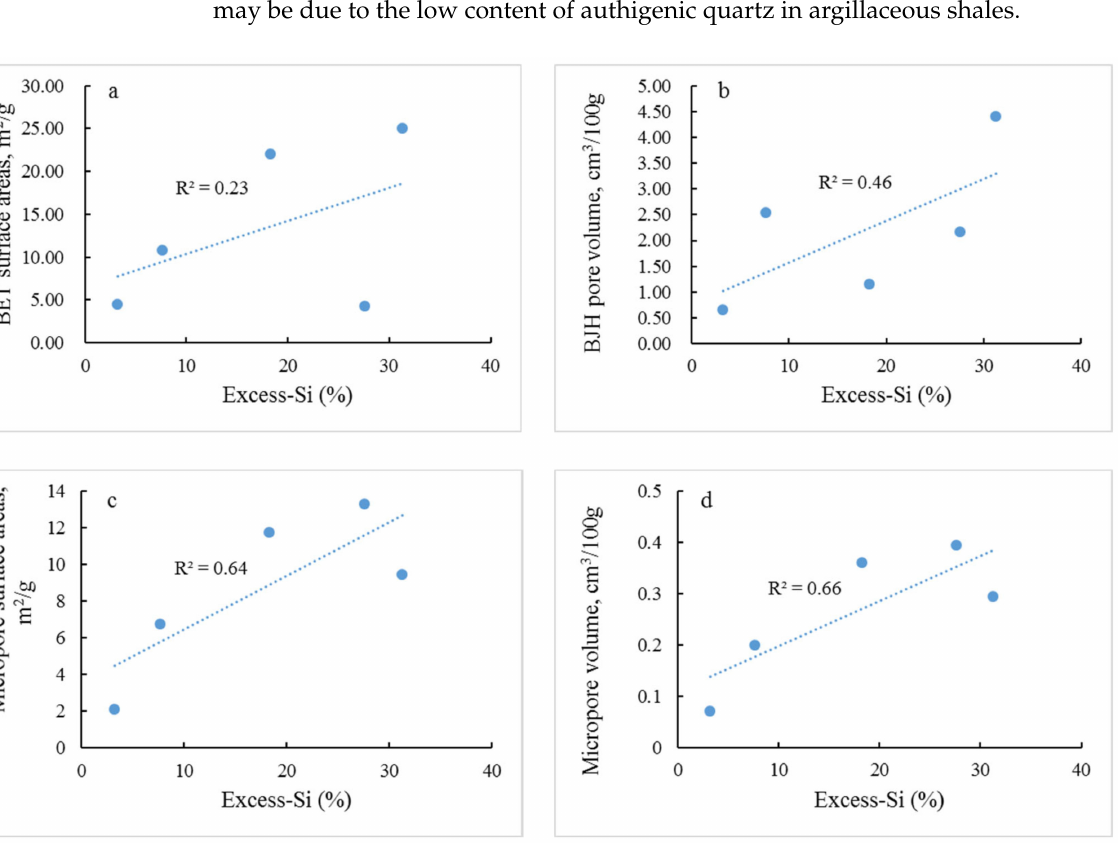
Figure 14. Mesopore surface areas and volume versus Excess-Si content ( a , b ); micropore surface areas and volume versus Excess-Si content ( c , d ) for siliceous